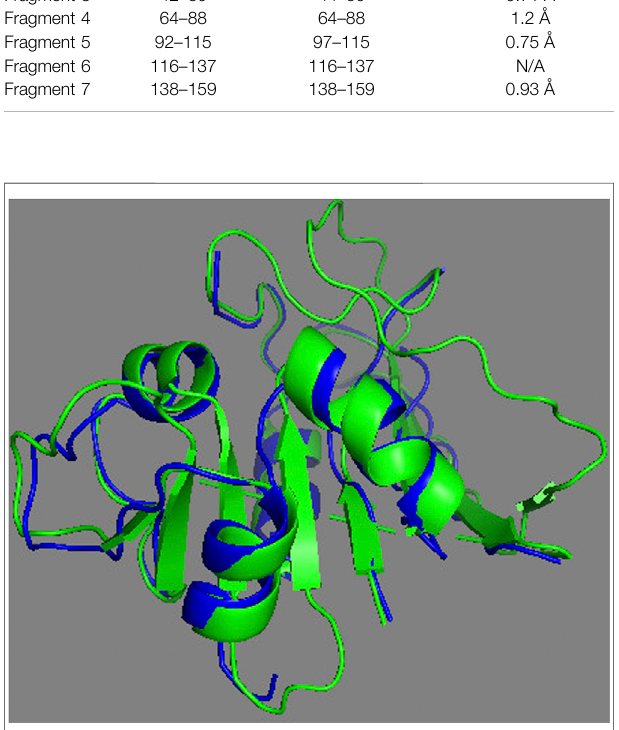
FIGURE 9 | Superposition of the calculated fragments by REDCRAFT (blue) and the X-ray structure of DHFR (green).